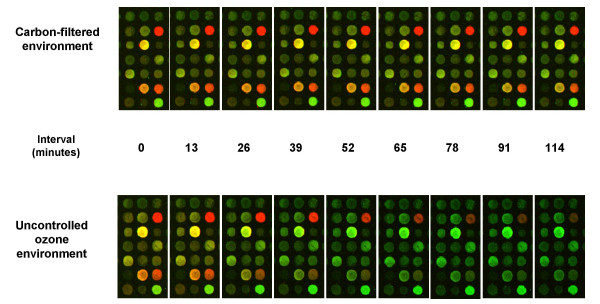
Reduction of Cy5 signal for in-house fabricated microarrays kept in a none-ozone controlled environment. These figures show a region of two 20 K mouse microarrays, selected because of their wide range of both Cy5 and Cy3 signals. The microarray images were from scans made during a 114 minute experiment interval. While the microarrays maintained in the carbon-filtered laboratory environment (ozone ~2–4 ppb) remained relatively unchanged with time (top images), reduction in Cy5 in the uncontrolled ozone environment (ozone ~25 ppb) causes the microarray image to have a predominantly green cast (bottom images).